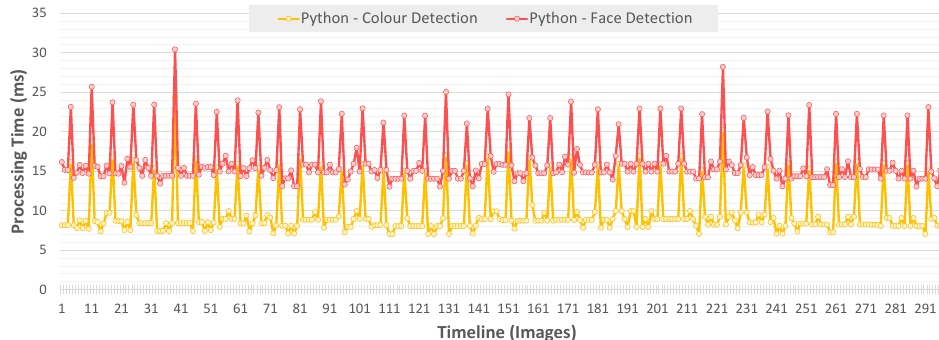
Figure 13. Total processing times of the colour and face detection algorithms in parallel execution in Python. For colour detection: average, 9.60 ms; minimum, 7.05 ms; maximum, 24.43 ms. For face detection: average, 16.10 ms; minimum, 13.05 ms; maximum, 30.43